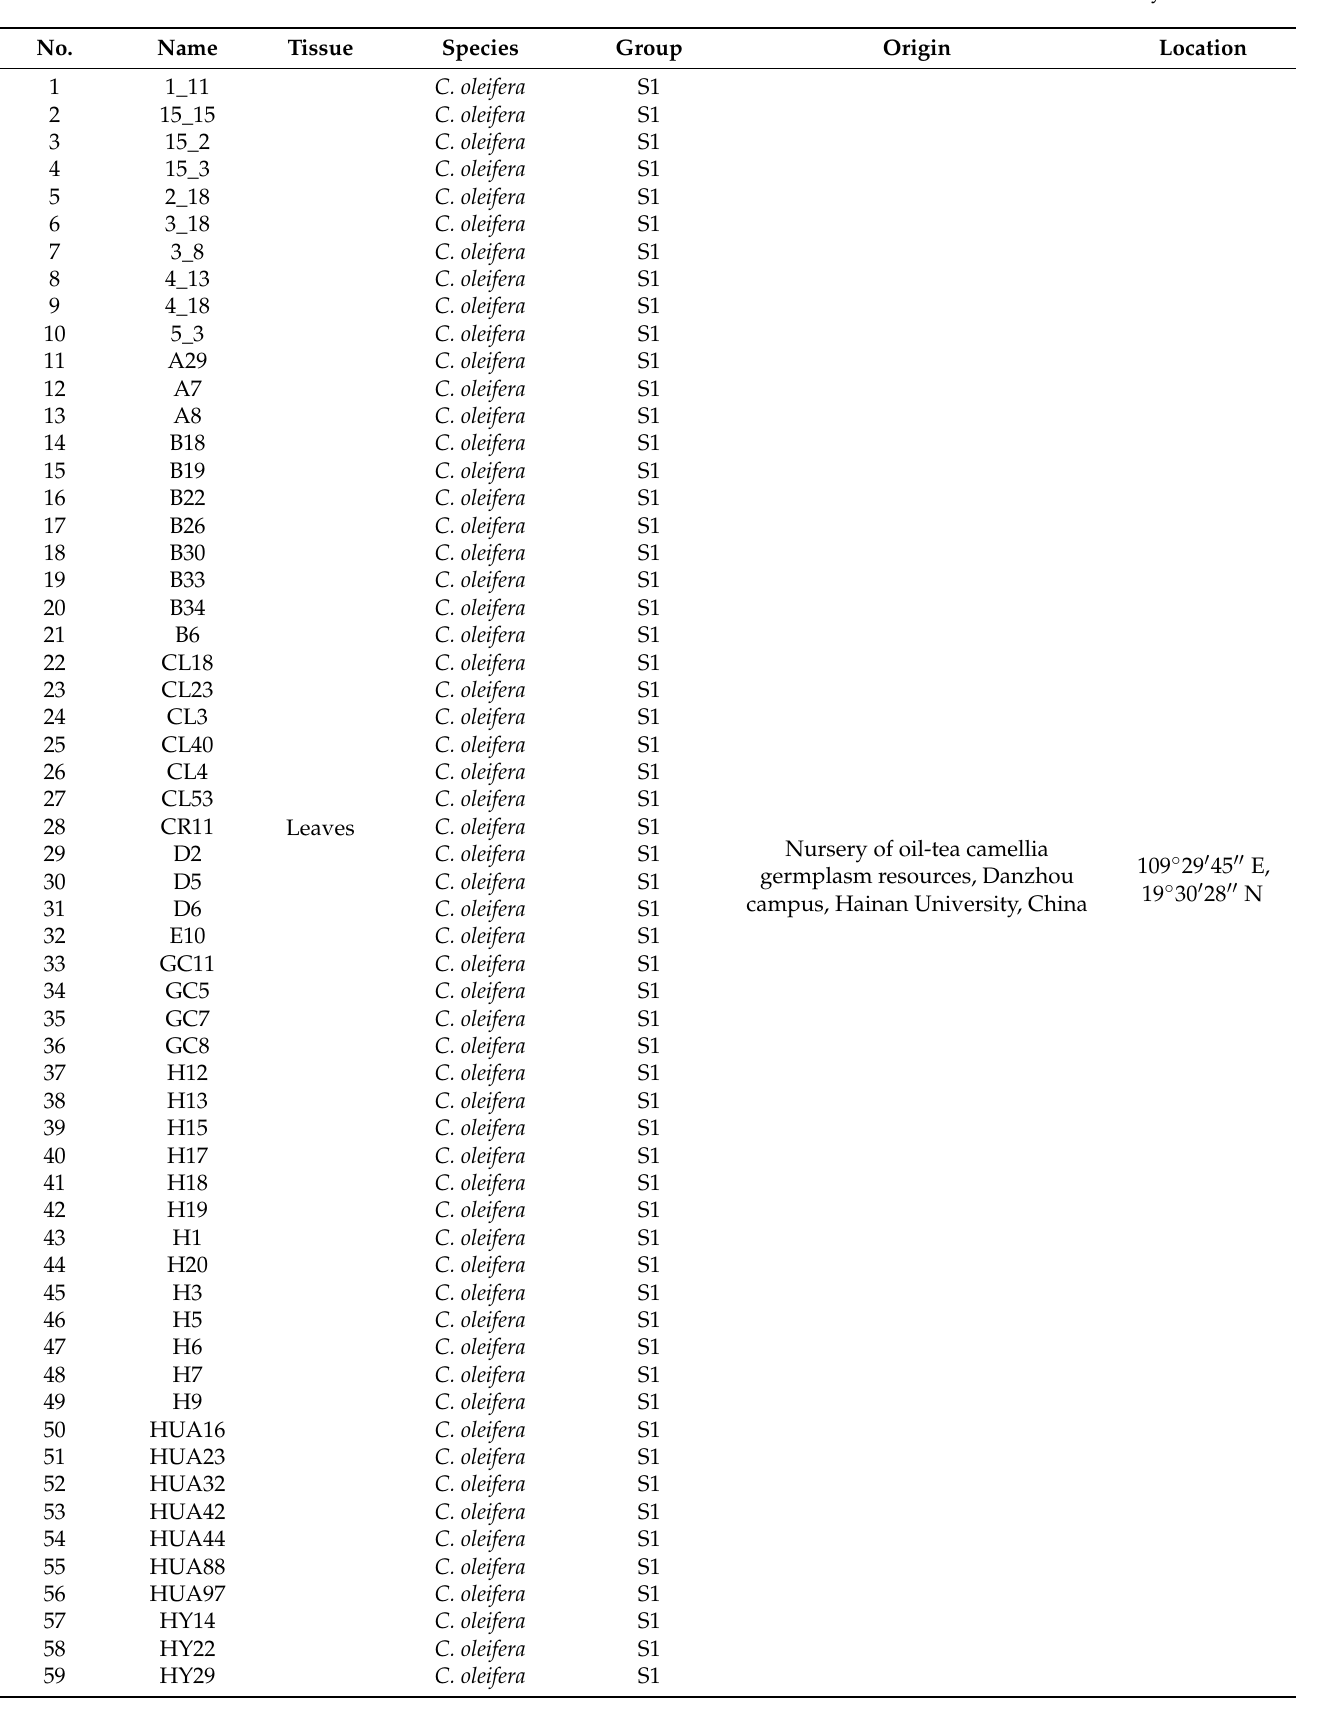
Table 1. Detailed information for the 140 oil-tea camellia accessions used in this